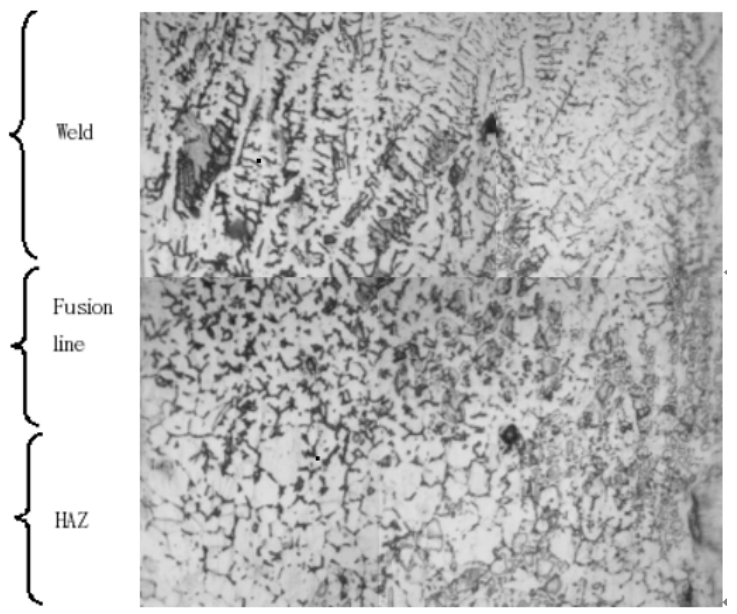
Figure 5. Collage of microstructures of a welded joint made of AISI 316L steel at low values of mode parameters ( × 500).